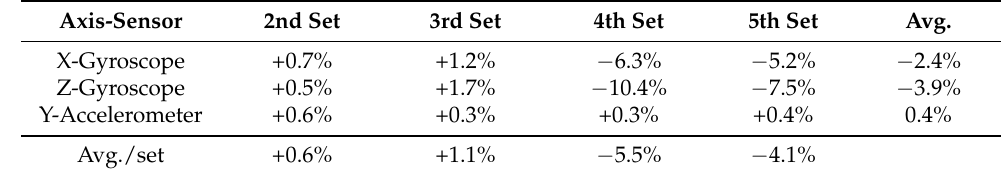
Table 4. The change in muscular endurance represented in vertical shrinks, compared to the 1st set. Axis-Sensor 2nd Set 3rd Set 4th Set 5th Set